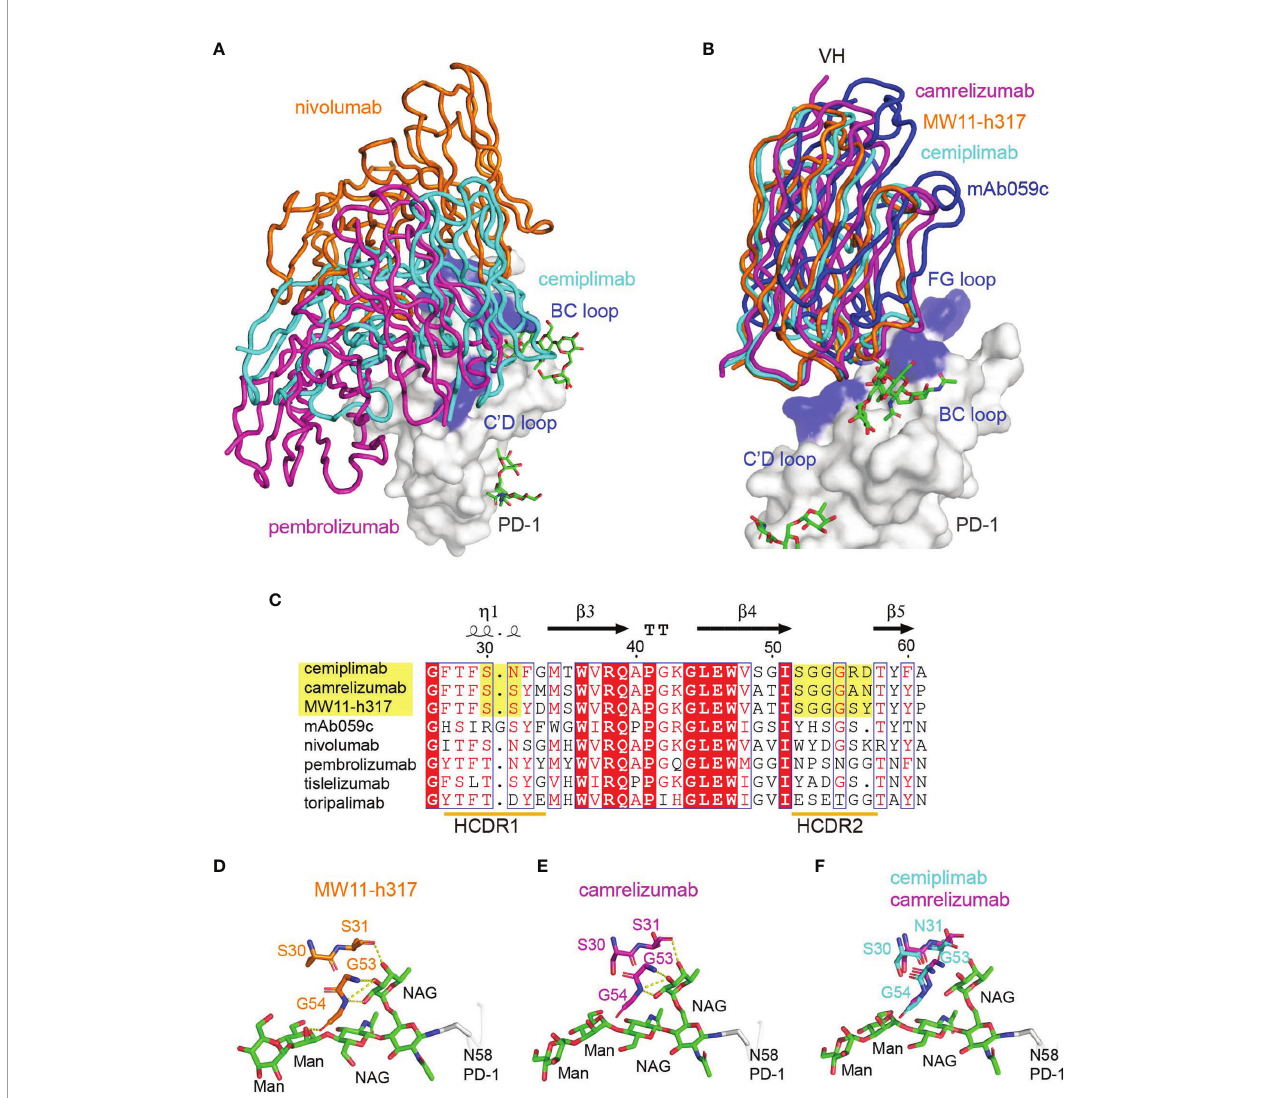
FIGURE 4 | Interaction between MAbs and N58 glycosylation on BC loop. (A) The comparison of the overall binding of cemiplimab, nivolumab, and pembrolizumab to PD-1. Superimposition of cemiplimab/PD-1 complex with that of pembrolizumab/PD-1 (PDB: 5JXE) and nivolumab/PD-1 (PDB: 5WT9). The cemiplimab, pembrolizumab, and nivolumab are shown as ribbon and colored in cyan, magenta, and orange, respectively. PD-1 extracted from camrelizumab/PD-1 (PDB code: 7CU5) complex is shown as surface representation colored in white. (B) Superimposition of cemiplimab/PD-1 complex with that of camrelizumab (PDB: 7CU5), MW11-h317 (PDB: 6JJP) and mAb059c (PDB: 6K0Y). The VH domains of the MAbs are shown as ribbons while the VL domains are not shown. PD-1, cemiplimab, camrelizumab, MW11-h317, and mAb059c are colored in gray, cyan, magenta, orange and blue, respectively. The CC ′ , C ′ D, and FG loops of PD-1, which participate in binding to Mabs are highlighted in blue. (C) Structure-based sequence alignment of cemiplimab and other anti-PD-1 MAbs. Coils above the sequences indicate a -helices, and the lines with arrowhead represent the b sheets. Residues highlighted in yellow are highly conserved. The sequence alignment was generated with ClustalX and ESPript. (D, E) The interaction of N-glycosylation N58 with MW11-h317 (D) or camrelizumab (E) . The amino acid residues involved in hydrogen bond interaction and N58 glycans are shown as sticks, with amino acids in MW11-h317 colored in orange, camrelizumab colored in magenta, and the glycans in PD-1 colored in green. Hydrogen bonds are labeled by yellow dashed lines. (F) Comparison of cemiplimab/PD-1 complex with that of camrelizumab (PDB: 7CU5), and the amino acids in cemiplimab are colored in cyan and residues in camrelizumab are colored in